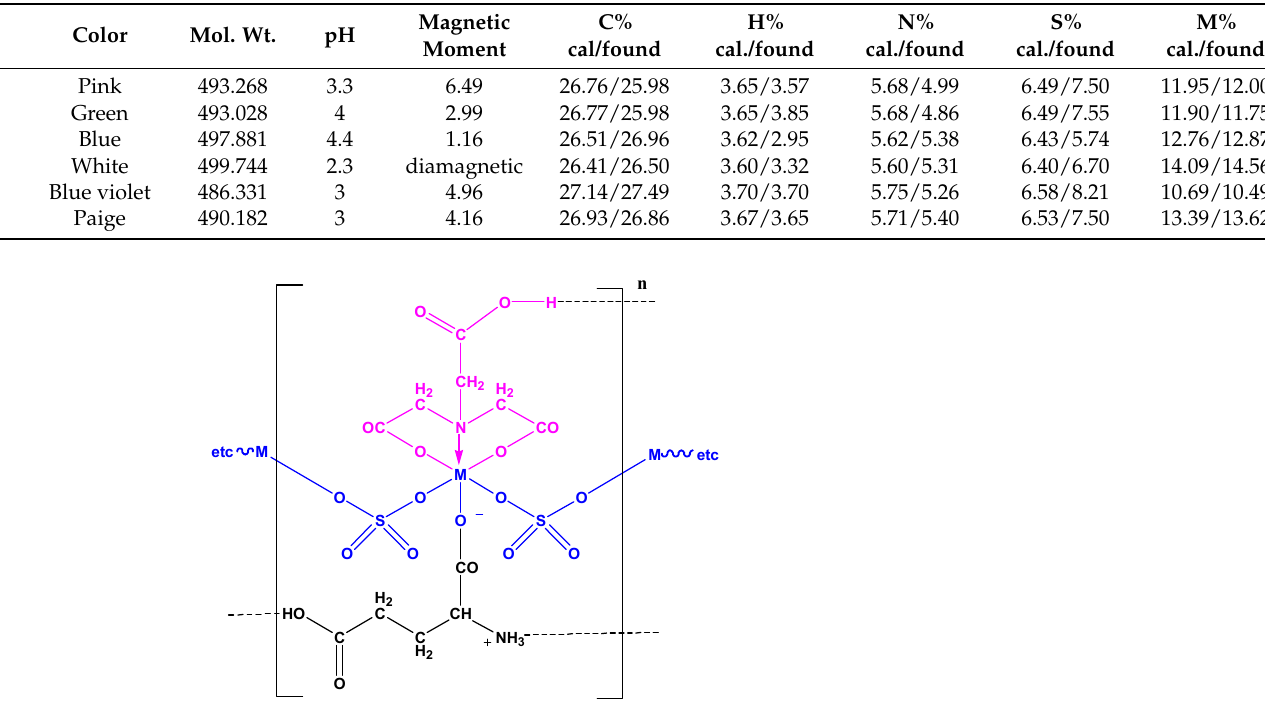
Table 1. Some physico-properties of the prepared coordination oligomers.